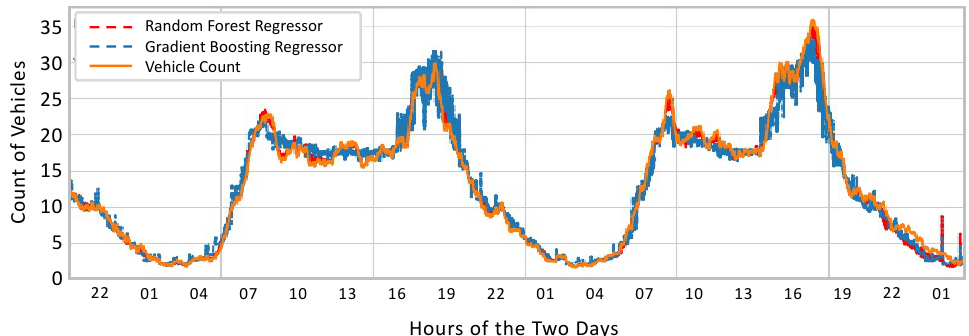
Figure 17. Random forest and gradient boost regressors when trained on partial day dataset, and tested for predicting two days of traffic.